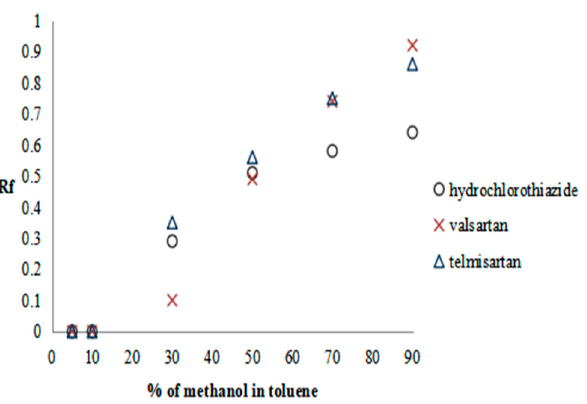
Figure 2. Plots of substance retention relationships vs. the mobile phase composition for the second group of drugs. Stationary phases: HPTLC silica gel 60 F 254 .